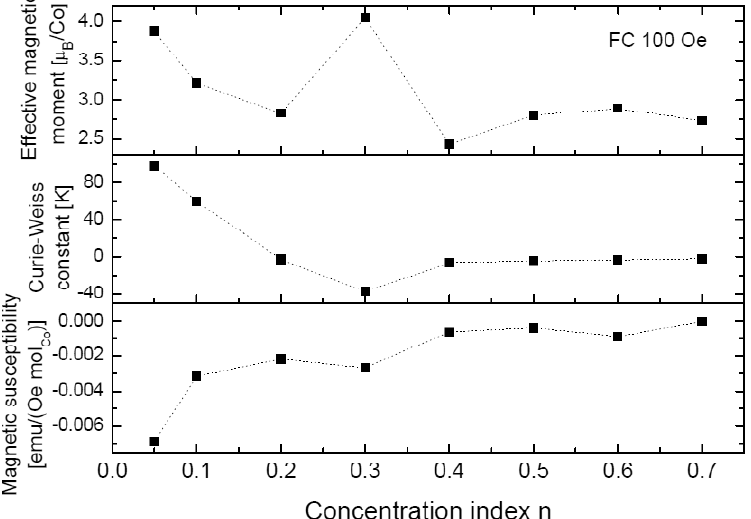
Fig. 3. Dependence of the effective magnetic moment  panel), and temperature-independent susceptibility 